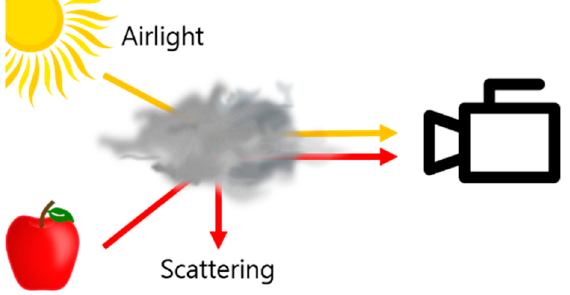
Figure 2. Atmospheric scattering model.